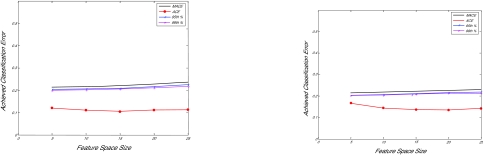
PACE analysis using a SVM-based classifier using the weighted separability scoring criterion, with a 0.6 MAC threshold. Left Panel: performance without peak selection. Right panel: performance with peak selection.